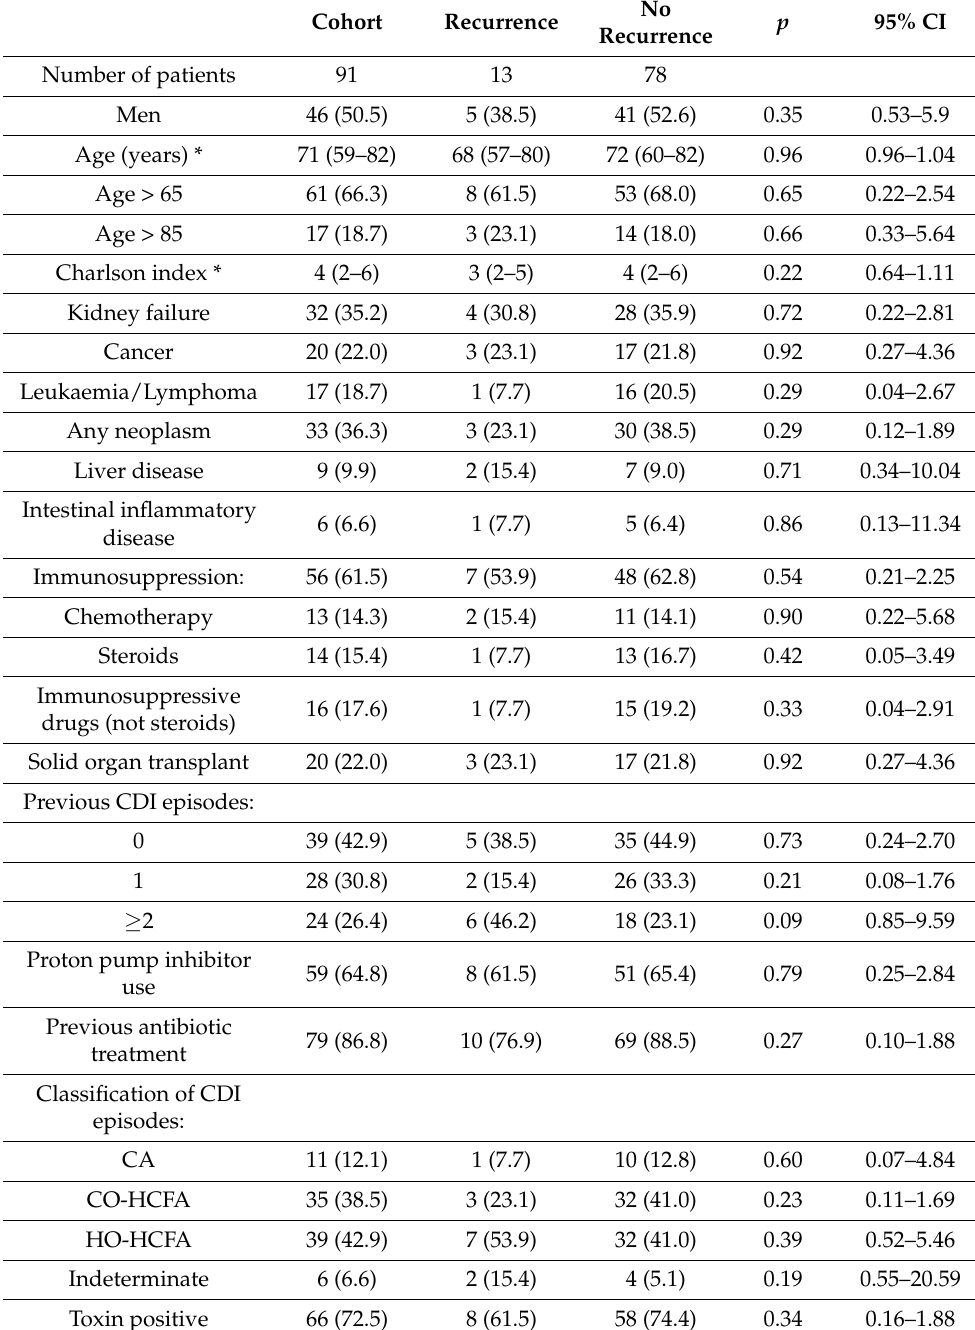
Table 2. Risk factors for recurrent Clostridioides difficile infection